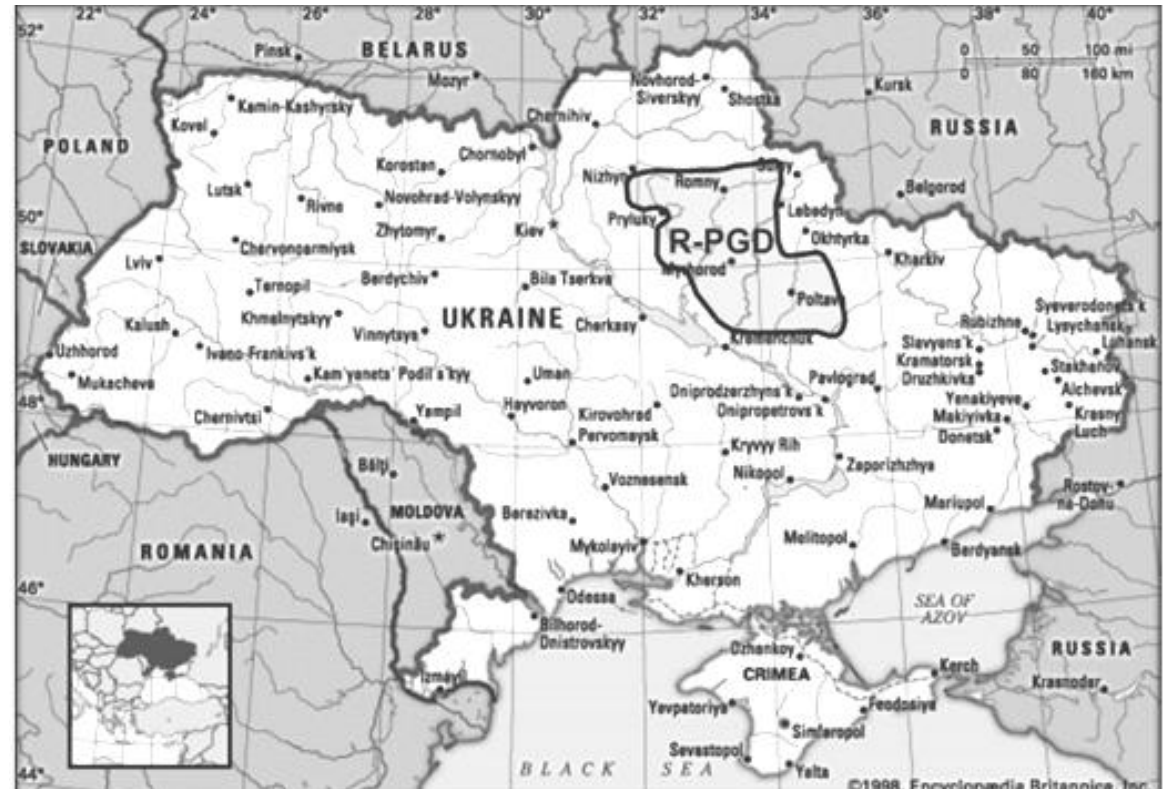
Fig. 1. The location of the Romensko-Poltavsky Geobotanical District (R-PGD) in